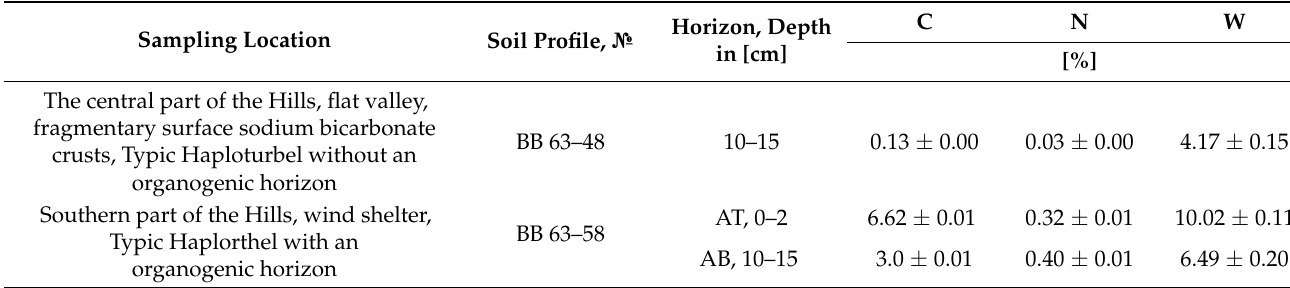
Table 1. Description of the samples.